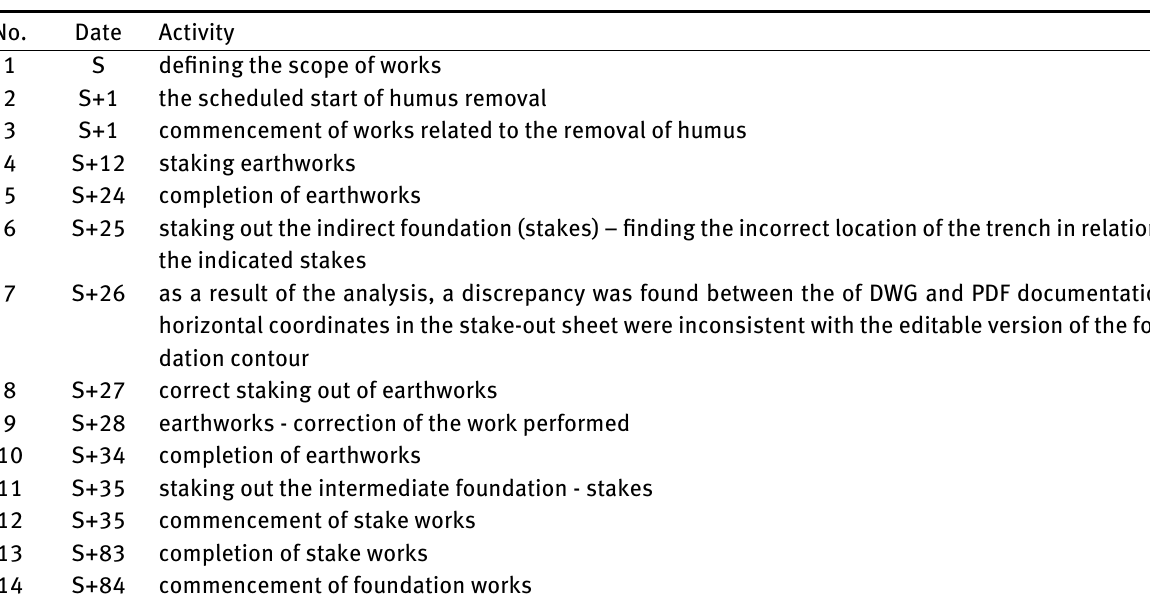
Table 1: Separated part of the schedule in which the R1 factor occurred, Source: own elaboration. No.